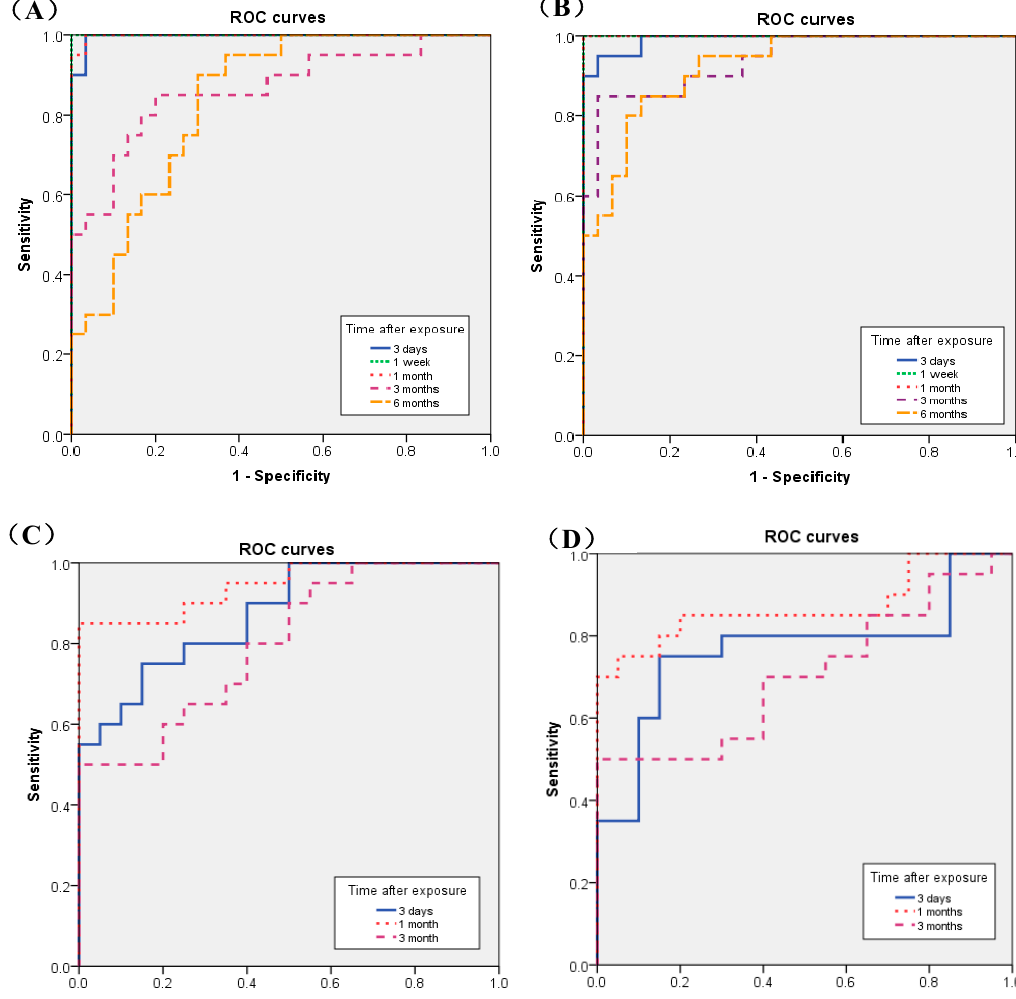
Figure 5. Receiver operating characteristics (ROC) for the toxicity of NMs by the concentration of CINC-1 and CINC-2. ( A ) CINC-1 in intratracheal instillation; ( B ) CINC-1 in inhalation exposure; ( C ) CINC-2 in intratracheal instillation; ( D ) CINC-2 in inhalation exposure. Table 2. Results of receiver operating characteristics (ROC) analysis in intratracheal instillation and inhalation exposure of NMs.